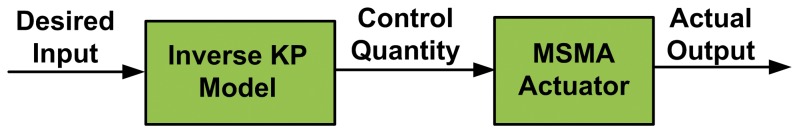
Feedforward control system for the MSMA actuator.The feedforward controller is an inverse KP model that can linearize the entire system by cascading MSMA actuators.